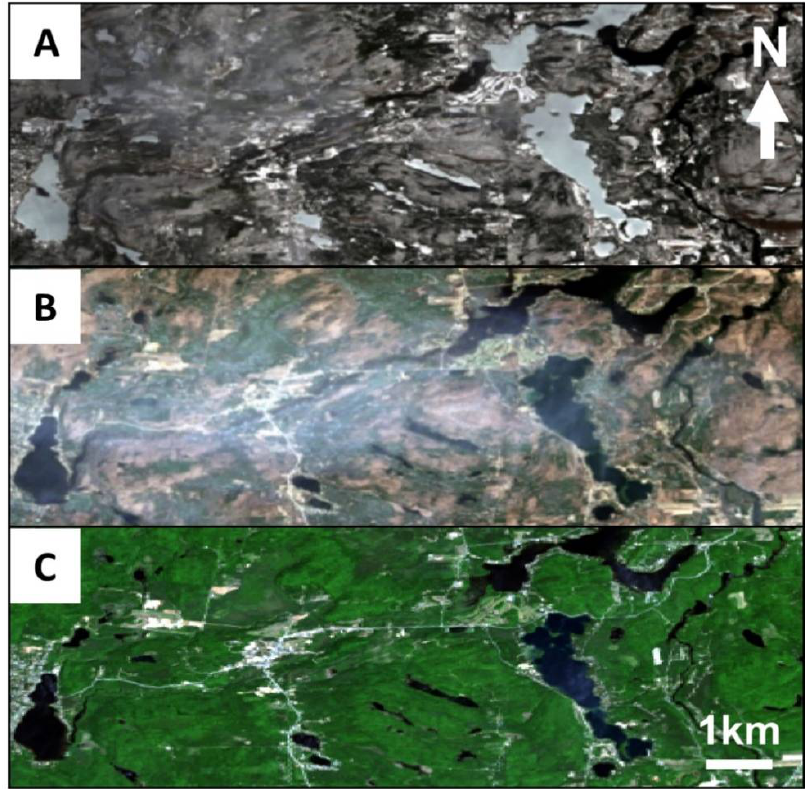
Figure 2. Time series of Landsat 8 true colour optical images (red-green-blue (RGB): 4-3-2) from the following scenes: ( A ) 13 April 2016; ( B ) 29 April 2016; and ( C ) 16 June 2016.